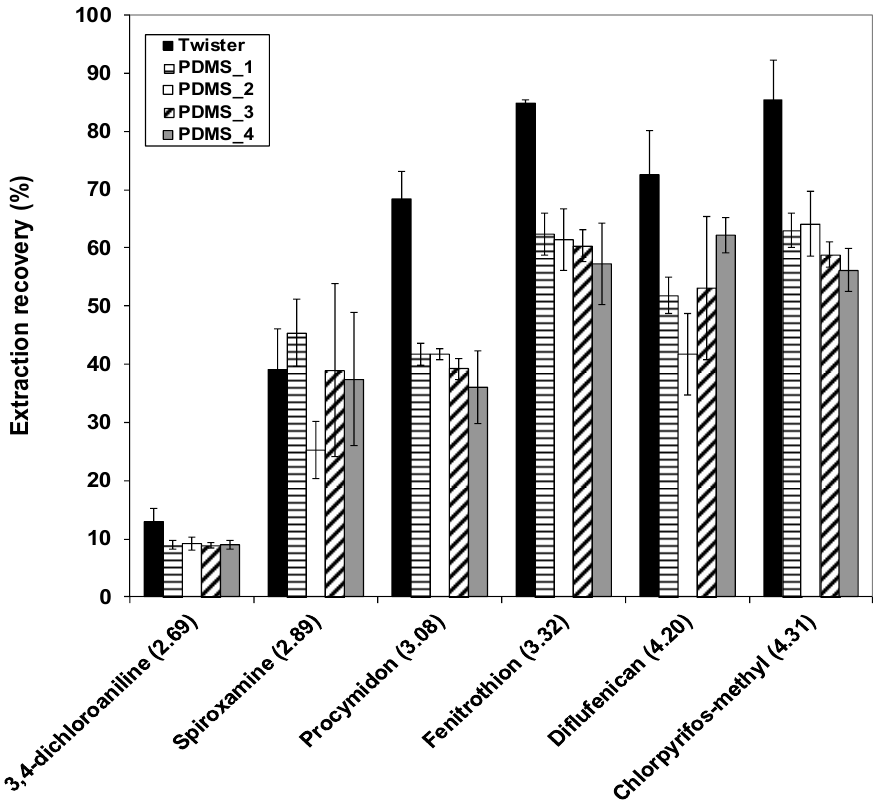
Figure 1. Recovery for the extraction of the target pesticides by the four types of synthesized polydimethylsiloxane (PDMS) rods and Twisters, at 700 rpm for 3 h. Numbers in brackets on the x axis are the octanol-water partitioning coefficients of the target pesticides (log K ), sorted by increasing values. Errors bars represent ± standard ow deviation ( n =